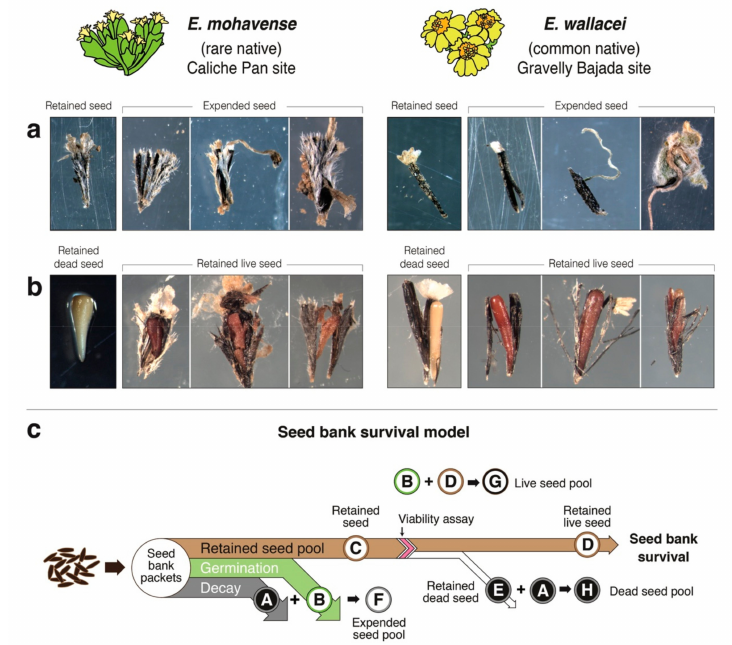
Figure 2. A seed bank survival conceptual model and photos of seed types in the seed bank; seed of both species are ~2 mm